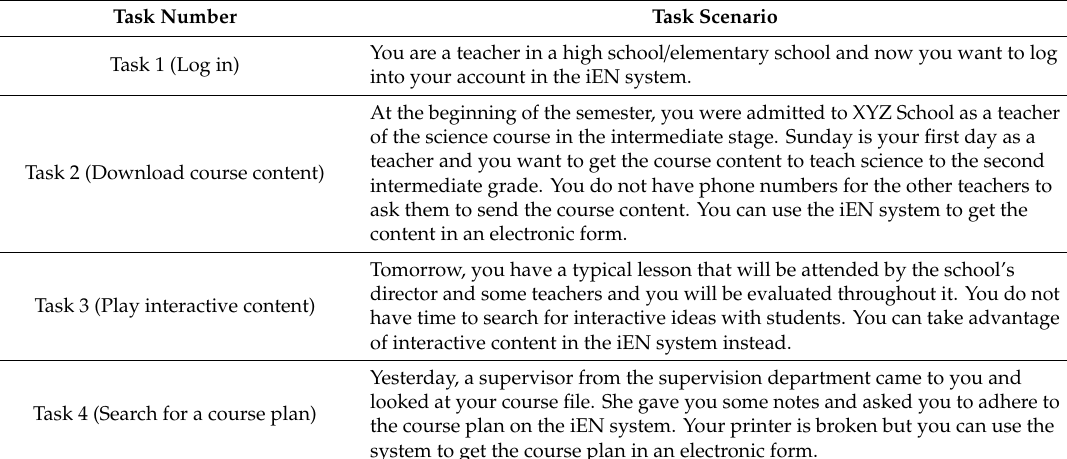
Table 6. iEN system task